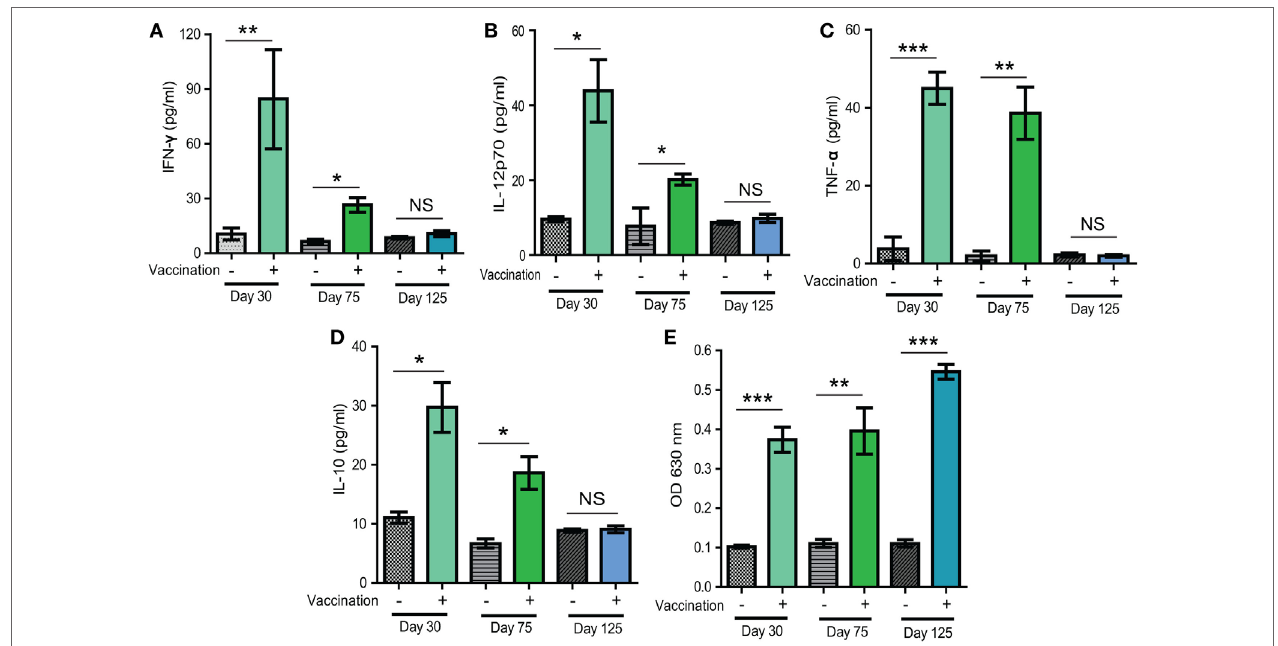
FigUre 6 | Levels of selected cytokines and Toxoplasma specific IgG in sera of mice 30, 75, and 125 days after Δ ldh immunization. (a–D) Levels of indicated cytokines measured by ELISA. (e) Relative levels of Toxoplasma specific IgG, as determined by indirect ELISA. Sera from naïve mice were used as controls and three mice from each group were analyzed. * p < 0.05, ** p < 0.01, *** p < 0.001, NS: not significant, Student’s t